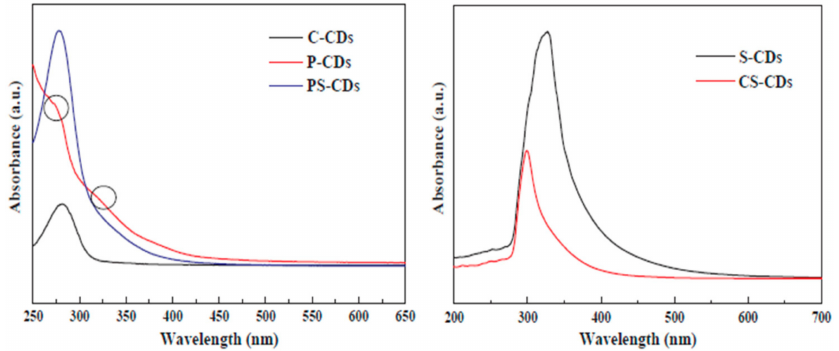
Figure 8. UV–vis spectra of ( left ) C-CDs, P-CDs, and PS-CDs and ( right ) CS-CDs and S-CDs. Adapted with permission from [108], Copyright {2020},